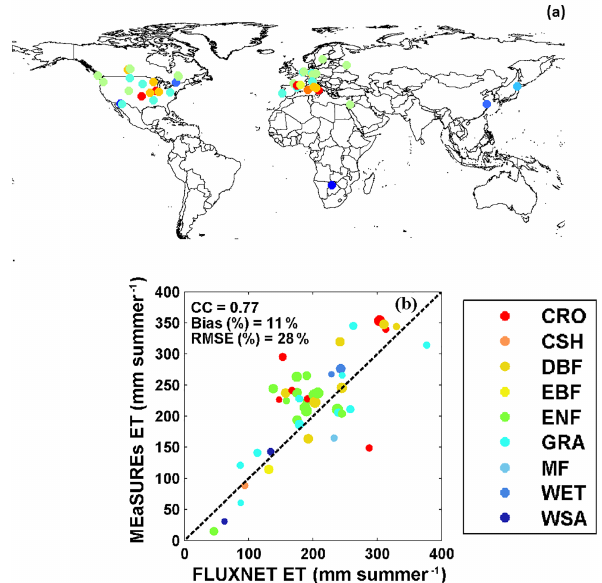
Figure 16. (a) Distributions of 47 flux towers over the globe; (b) validation of MEaSUREs ET estimates against FLUXNET observa- tions. Different colors in panel (b) represent different International Geosphere-Biosphere Programme (IGBP) land cover types (Love- land et al., 2000); the sizes of dots represents the data record length (ranging from 1 to 10 years) from FLUXNET. IGBP land cover types include (1) CRO: cropland; (2) CSH: closed shrubland; (3) DBF: deciduous broadleaf forest; (4) EBF: evergreen broadleaf for- est; (5) ENF: evergreen needleleaf forest; (6) GRA: grassland; (7) MF: mixed forest; (8) WET: permanent wetland; (9) WSA: woody savanna.